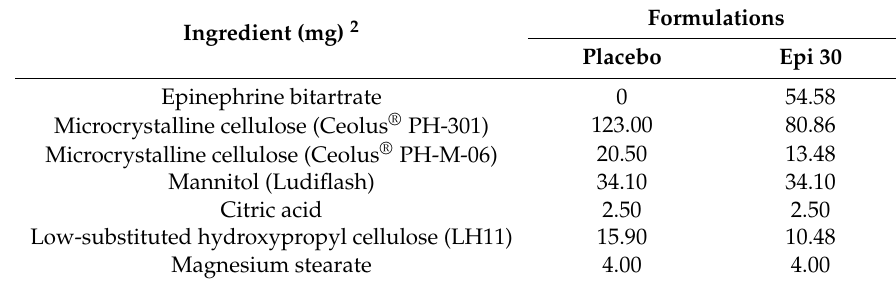
Table 1. The type and amounts of ingredients used in the taste-masked rapidly-disintegrating sublingual tablet formulations 1